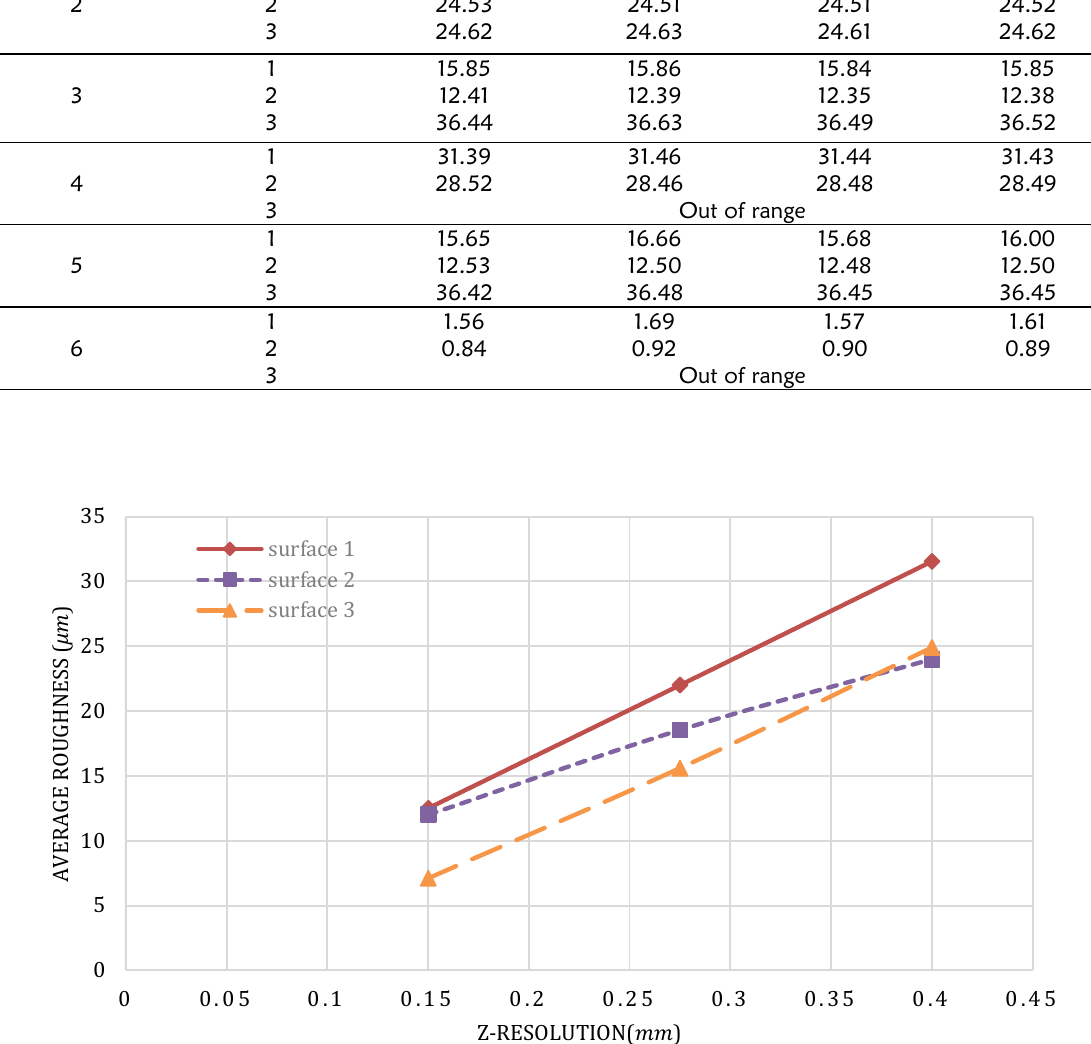
Table 2: The value of surface roughness for each surfaces of each samples SAMPLE No.